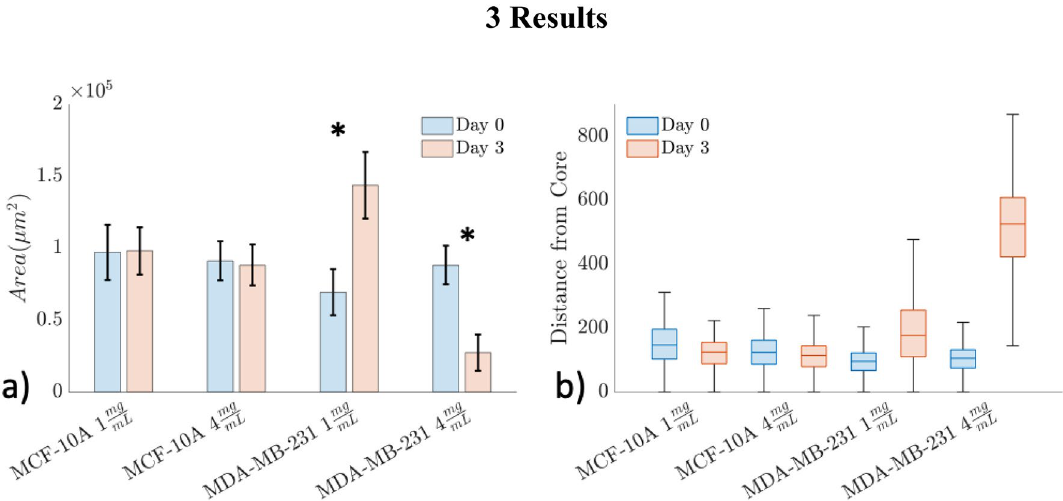
Figure 2. Spheroid morphology over time. ( a ) The total area occupied by spheroids in each group are separated by Day 0 (blue) and Day 3 (red). Each bar represents the mean and standard deviation across the three replicates. For each condition, Day 0 (blue) was compared to Day 3 (orange) using a t-test and significance was indicated with ( a ) * (p < 0.05). The MDA-MB-231 samples had a significant increase in spheroid area at 1 mg/ml and a significant decrease at 4 mg/ml. ( b ) The distance of every pixel from its spheroid center for each condition separated by Day 0 (blue) and Day 3 (red). The whiskers represent 5% and 95%, the box represent 25% and 75%, and median is indicated on the boxplot. The MDA-MB-231 samples had a modest increase in migration distance at 1 mg/ml and a much larger increase at 4